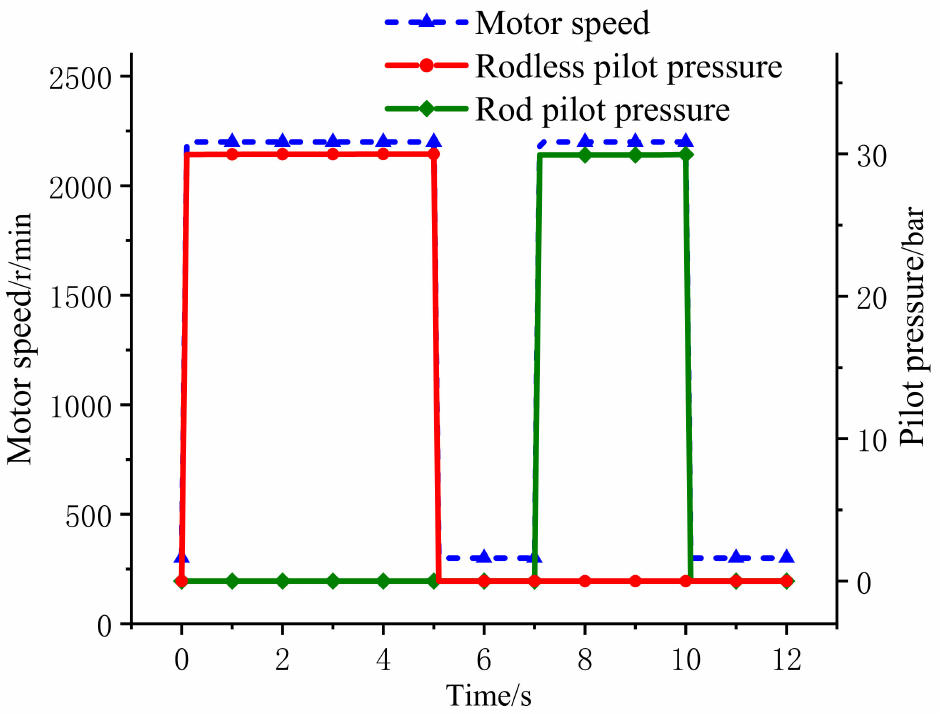
Figure 12. Relationship curve between the pilot pressure and electric motor